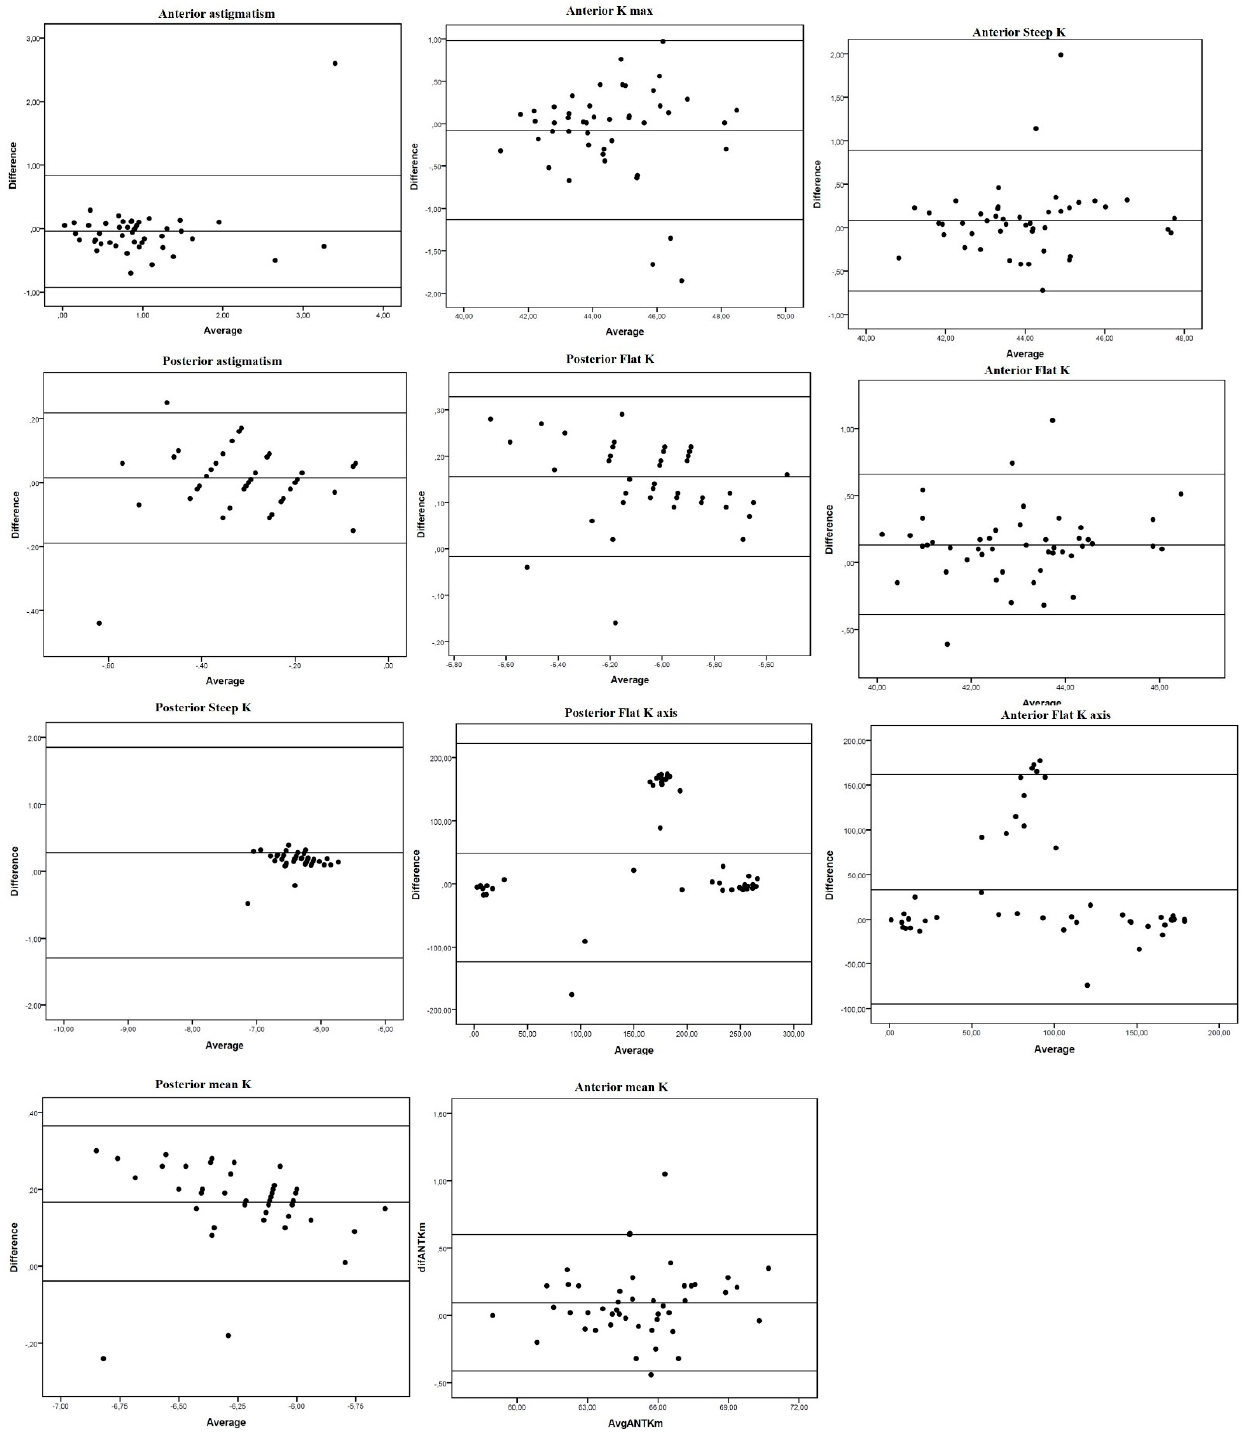
Figure 1. Bland-Altman plots of mean differences against averages of anterior and posterior corneal surface keratometry readings. Mean, lower and upper limits of agreement (±1.96 SD, standard deviation). Left: anterior vertical coma. Right: total vertical coma.